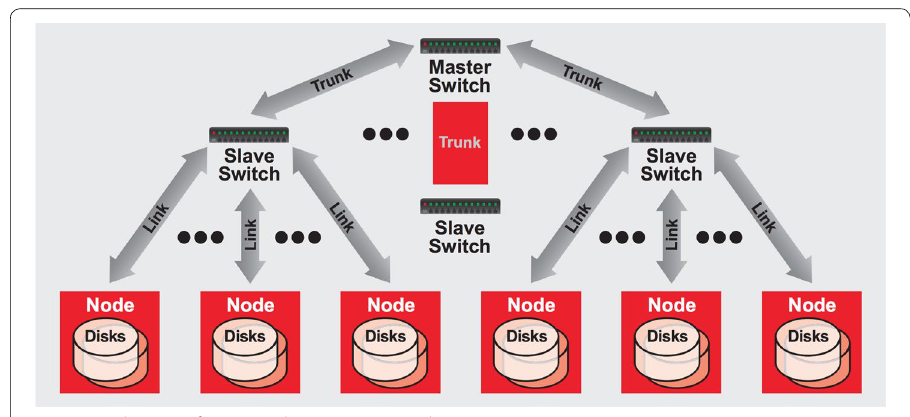
Fig. 1 Visualization of an example HPCC systems